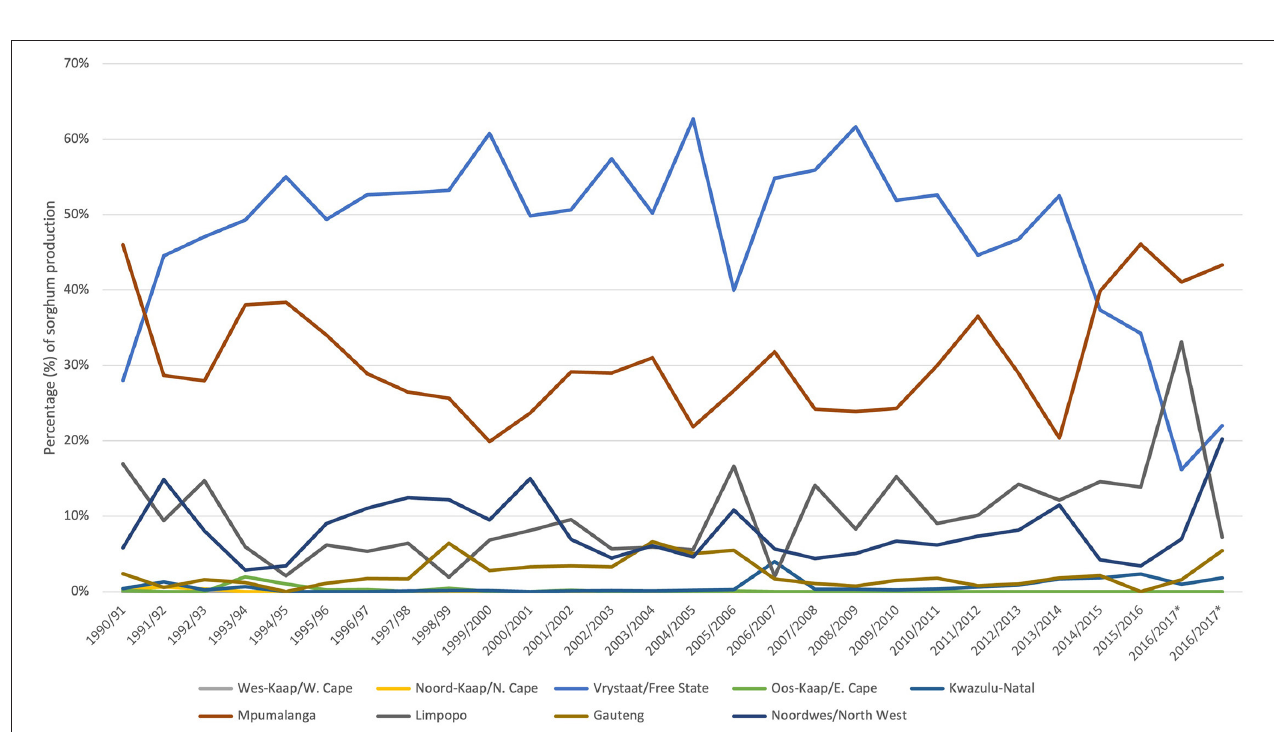
FIGURE 3 | Percentage of sorghum production (tons) by province 1990–2017 (Source data: GRAIN